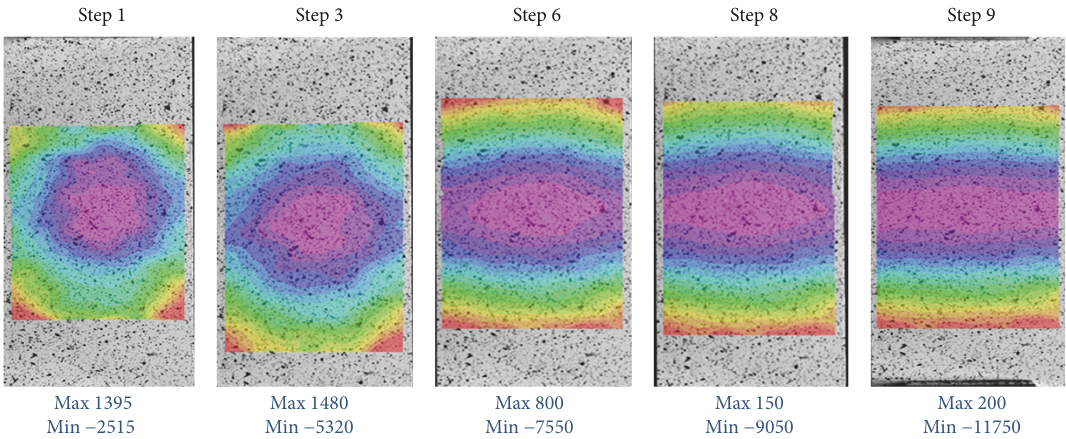
Figure 12: Surface strain-principal step-central delamination specimen [ 𝜇𝜀 ].